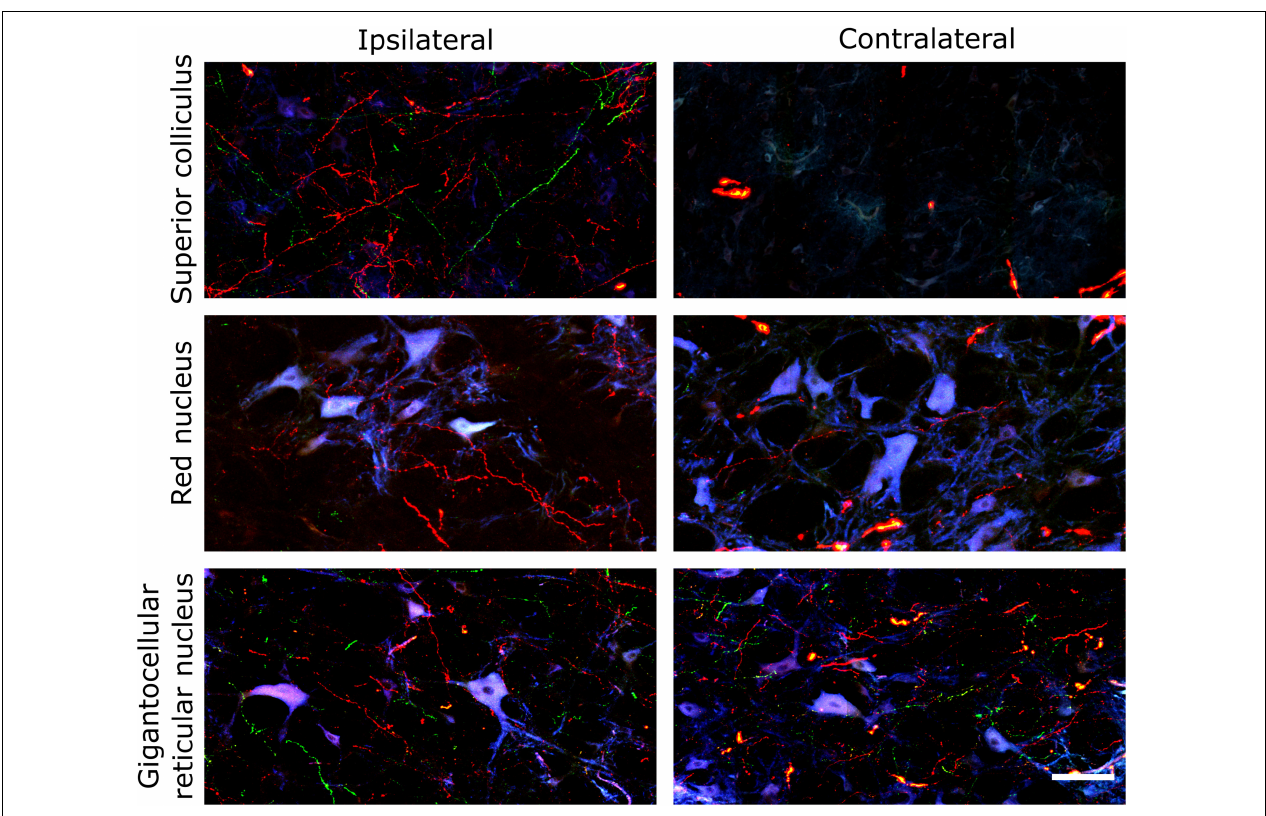
FIGURE 7 | Axonal projections from the porcine cerebral cortex to the midbrain and medulla oblongata. Confocal fluorescence images illustrating M1 and PM innervation of the superior colliculus, red nucleus and gigantocellular reticular nucleus of both sides. The images were captured with a confocal microscope (Leica TCS SP5) using a 20X objective. Neurons are shown in blue taking advantage of their autofluorescence. Scale bar, 100 µ